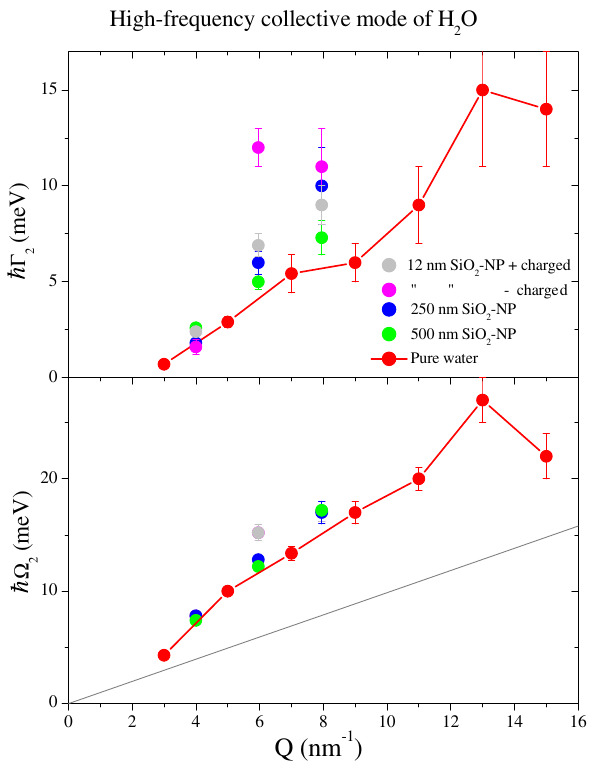
Figure 2. Lower panel: Best-fitting values of the high-frequency Damped Harmonic Oscillator (cid:31) 2 are reported as a function of Q . They were obtained from the modeling of IXS spectra of aqueous vSiO 2 -NP suspension and pure water, as indicated in the legend. Previous IXS results on pure water from Ref. 4 are also reported for comparison. The straight line represents the hydrodynamic dispersion law c s Q with c s being the adiabatic sound velocity of water 30 . Upper panel: corresponding values of the damping coefficient Ŵ 2